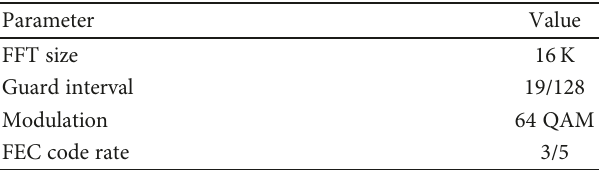
Figure 5: Measurement setup in urban areas. Table 1: Parameters of broadcasting at the